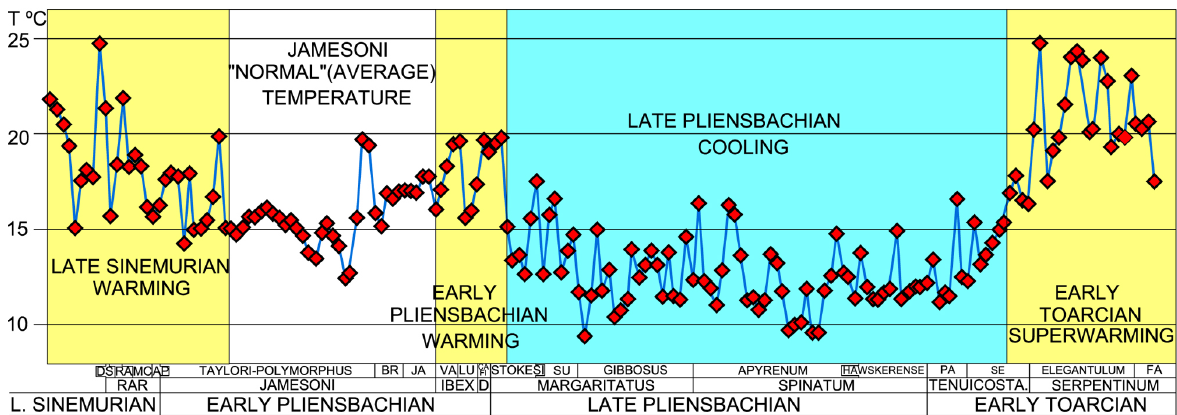
Figure 7. Curve of seawater palaeotemperatures of the Late Sinemurian, Pliensbachian and Early Toarcian, obtained from belemnite calcite in the Rodiles section of Northern Spain. Two warming intervals corresponding to the Late Sinemurian and the Early Pliensbachian are followed by an important cooling interval, developed at the Late Pliensbachian, as well as a (super)warming event recorded in the Early Toarcian. Chronozones abbreviations: RAR: Raricostatum. D: Davoei. TENUICOSTA.: Tenuicostatum. Subchronozones abbreviations: DS: